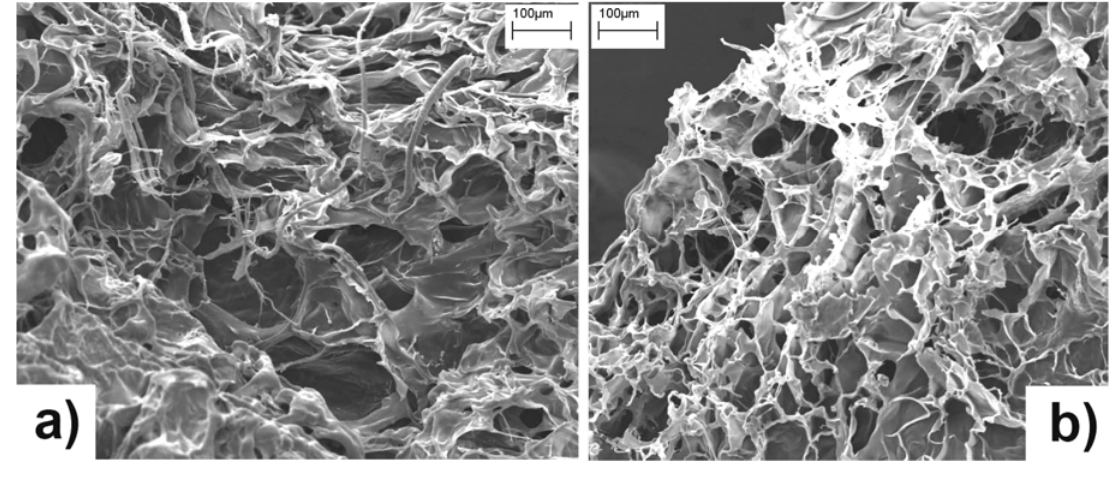
Figure 4. SEM micrographs of freeze-dried hC ( a ) and hA ( b )